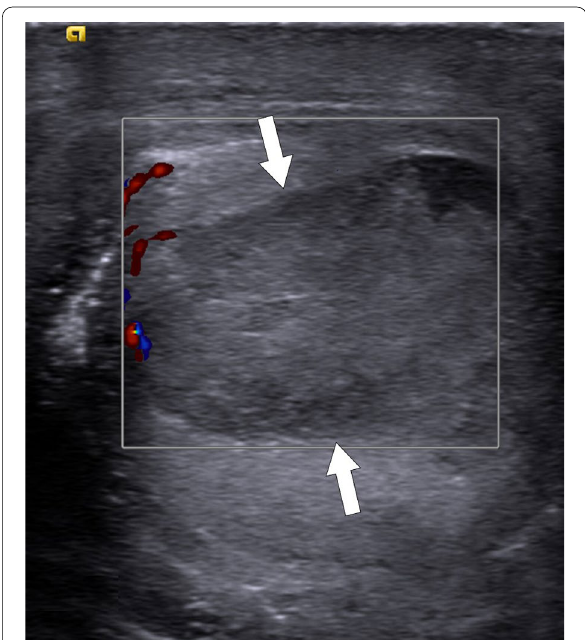
Fig. 7 Testicular abscess. A 18-year-old male with known neurogenic bladder due to myelomeningocele presenting with high fever, right testicular swelling, and severe scrotal pain. Color Doppler US image shows heterogeneous, hypoechoic lesion (arrows) with no significant internal vascularity. Note was also made of scrotal skin thickening and edema. As the patient was almost septic, an emergent right orchiectomy was performed. Histopathological examination confirmed severe testicular inflammation and abscess formation